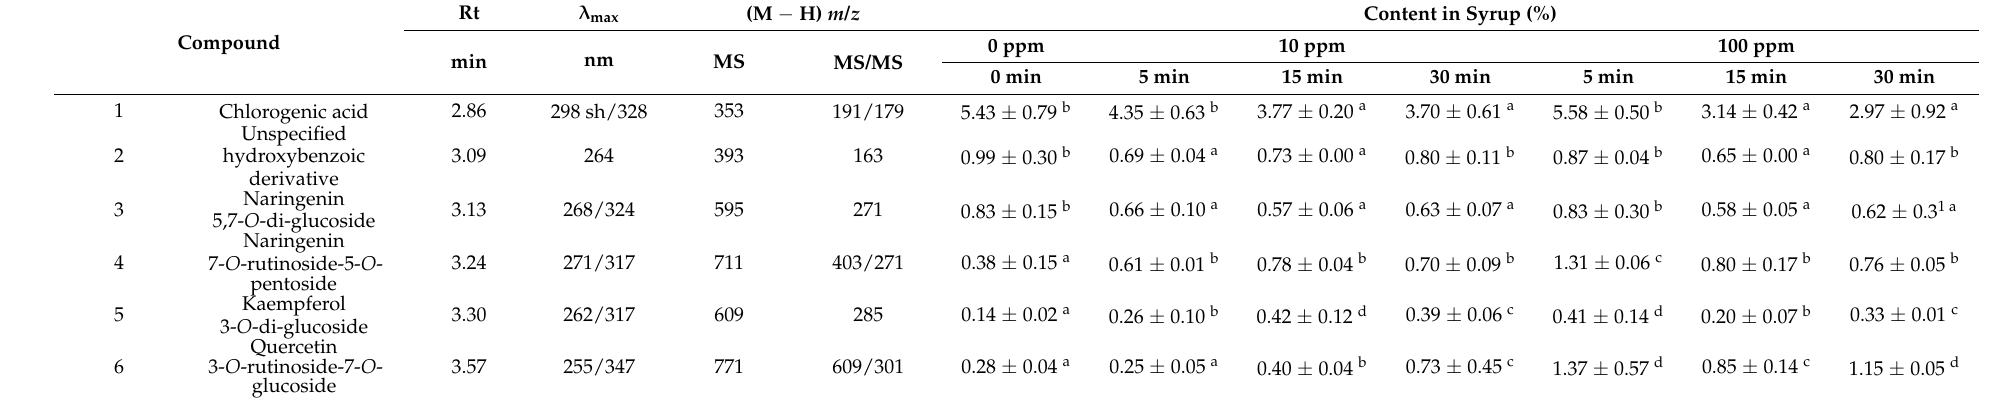
Table 2. Content (%) of individual phenolic compounds identified by UPLC–PDA–MS/MS in a syrup prepared with sugar syrup at a temperature of 60 ◦